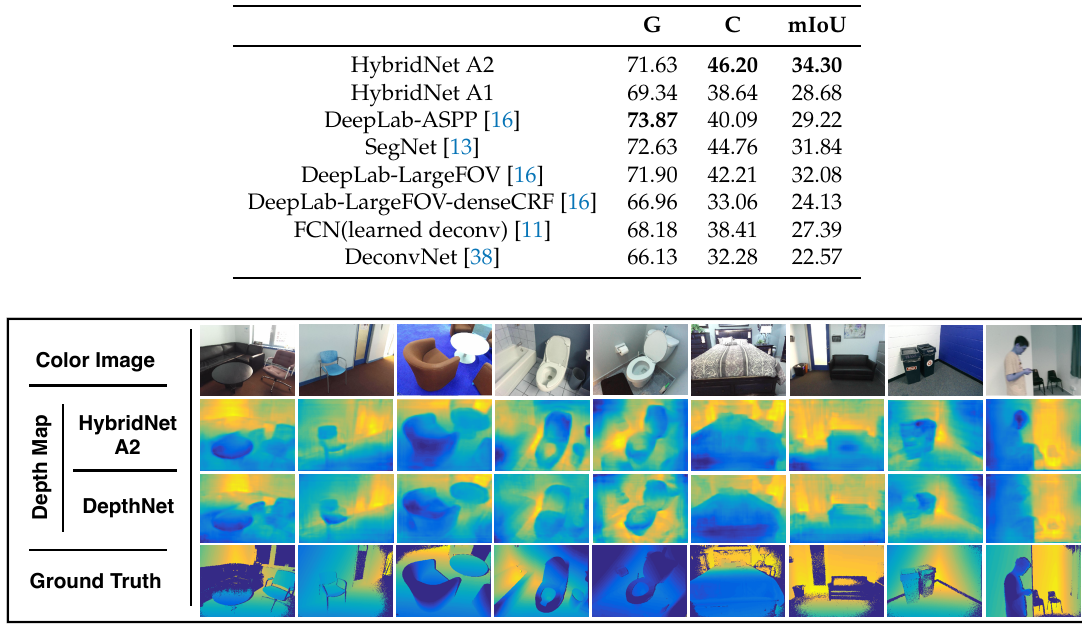
Table 5. Semantic segmentation. Quantitative evaluation (best results in bold).